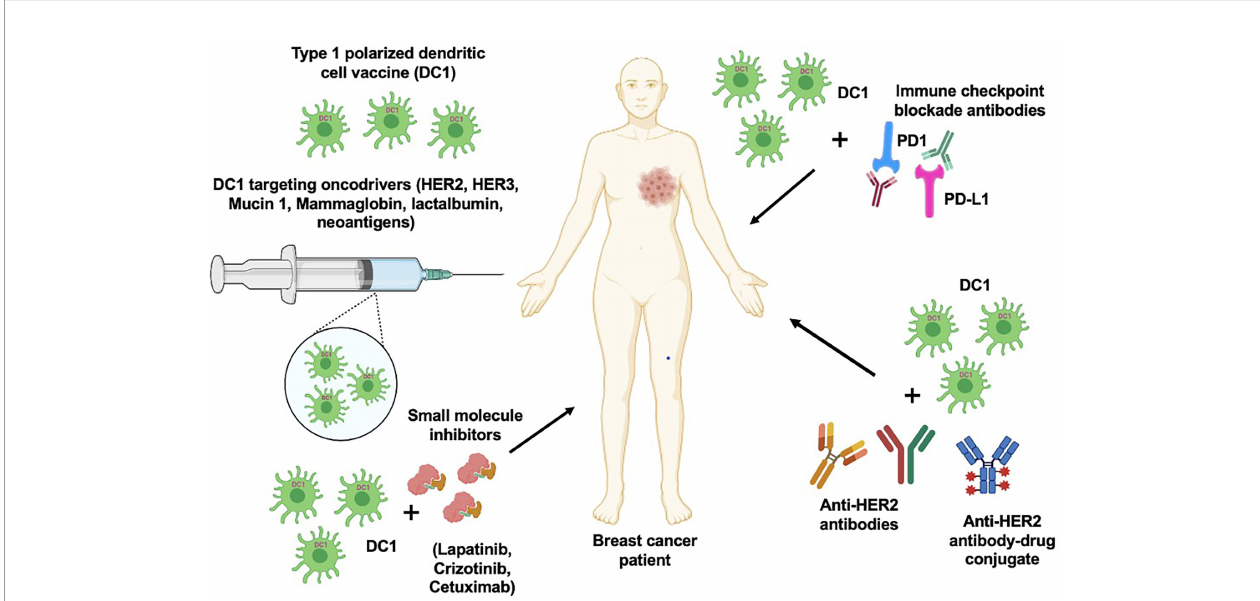
FIGURE 2 | DC1 vaccine with combination therapeutic approach. DC1 vaccination targeting various oncodrivers such as HER2, HER3, mucin 1, lactalbumin and neoantigens can be an effective strategy to improve therapeutic ef fi cacy and survival outcome in breast cancer patients. In addition, combination of DC1 vaccine with clinically available targeted therapies such as anti-HER antibodies, small molecular inhibitors and immune checkpoint blockade antibodies can also enhance the patient